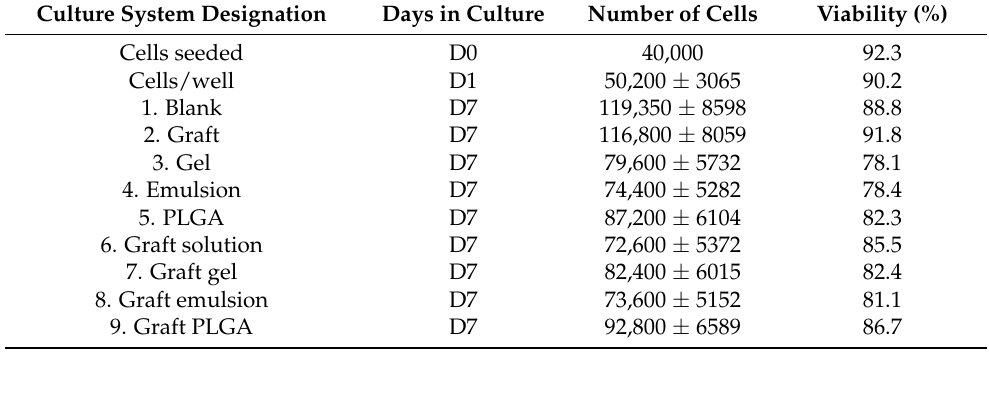
Table 3. Proliferation rates and viabilities of MSCs in different carriers.